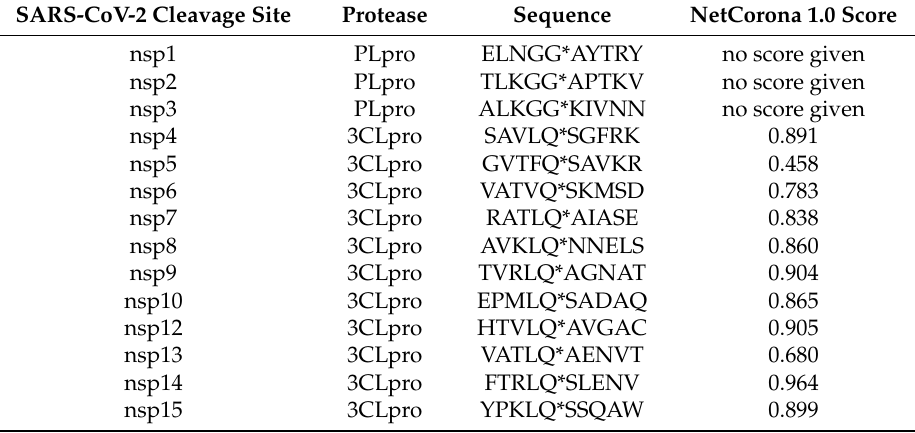
Table 1. Prediction of cleavage sites of SARS-CoV-2 polyprotein by NetCorona 1.0 webserver. Sequence of SARS-CoV-2 polyprotein was used as input [31]. Values lower than the threshold (0.5) are not predicted as a potential cleavage site. Cleavage positions are shown by asterisks.